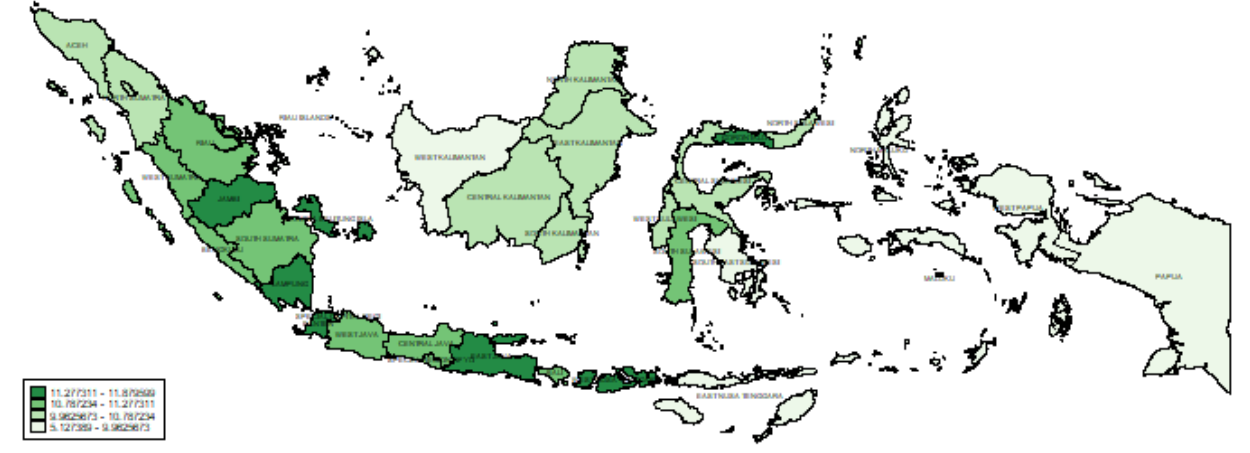
Figure 2. Mean presence of an information systems by province.